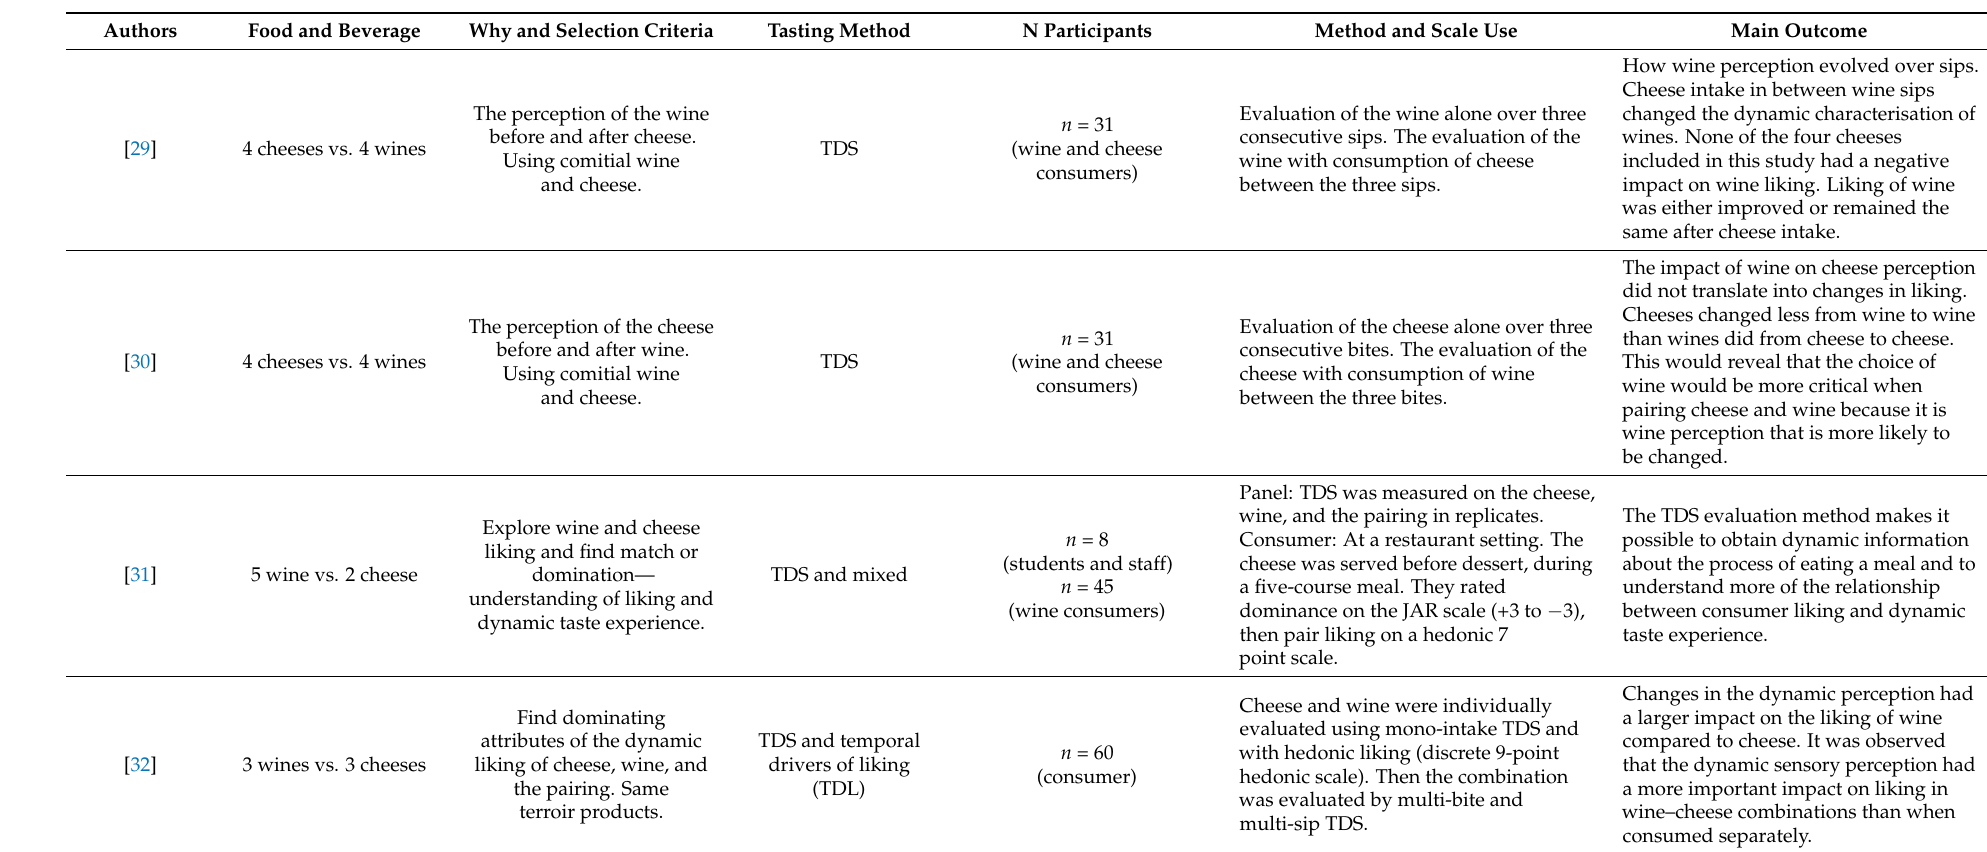
Panel: TDS was measured on the cheese, wine, and the pairing in